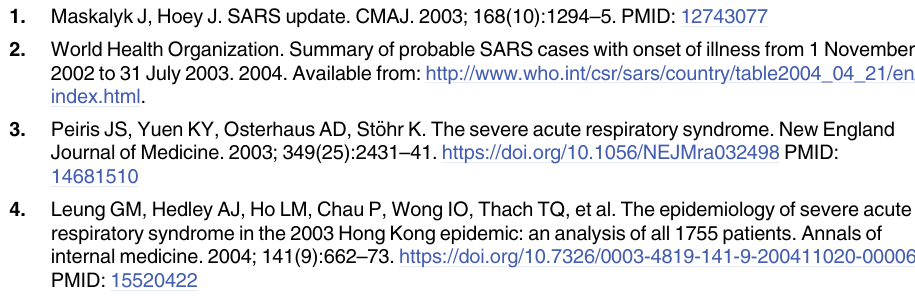
S1 Table. Top ranked 90 anti-viral drugs out of 3410 against SARS-CoV-2 infections pro- posed by Beck et al. [25]. S2 Table. List of significant DEGs between SARS-CoV-1 and control samples, where 86 DEGs are upregulated and the rest 52 DEGs are downregulated, and bold DEGs indicate as Hub-DEGs (HubGs). S3 Table. The list of Hub-DEGs (HubGs) which are selected from protein-protein interac- tion (PPI) analysis according to topological measure degree ( > 10) in STRING database. S4 Table. List of key chemicals, TFs and miRNAs those are interacted with DEGs and HubGs of SARS-CoV-1. S5 Table. List of diseases those are associated with at least one HubGs based on DisGeNET